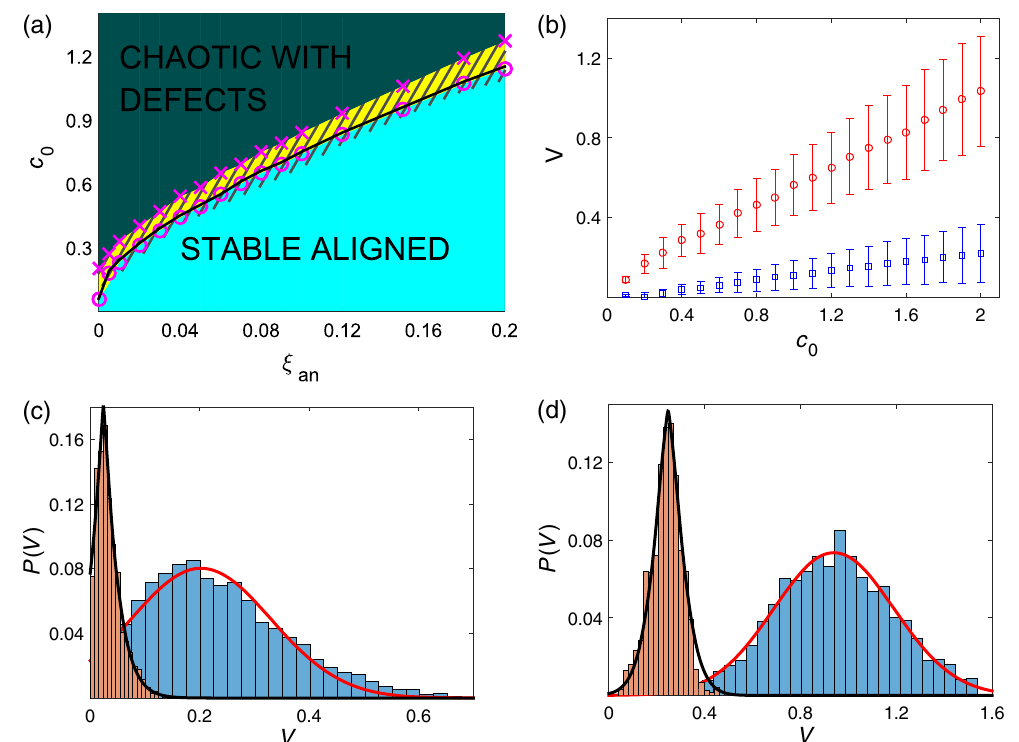
FIG. 3. Characterization of defect dynamics. (a) Phase diagram. Symbols circle, times depict the simulations results. The black solid line indicates the linear stability limit, Eq. (9). Stable director undulations exist between defect and homogeneous aligned states (yellow band). The transition boundaries are obtained by gradually increasing the average concentration c 0 from a slightly perturbed homogeneous initial condition. Hatching shows the hysteresis band where nonvanishing defects coexist with the undulated or homogeneous aligned states, τ ¼ 66 . 6 (corresponding, approximately 20 – 30 sec for the conditions of our experiment). (b) Mean ¯ V velocity of þ 1 = 2 defects (circle, red) and − 1 = 2 defects (square, blue) vs c 0 . Error bars are the velocity standard deviations. The ¼ 0 and for c ¼ 1 . 8 (blue) and c ¼ 0 . 3 (brown). Red solid lines are velocity distributions for − 1 = 2 (c) and 1 = 2 defects (d) for ξ 0 0 an Gaussian fits and solid black lines are the stretched exponential